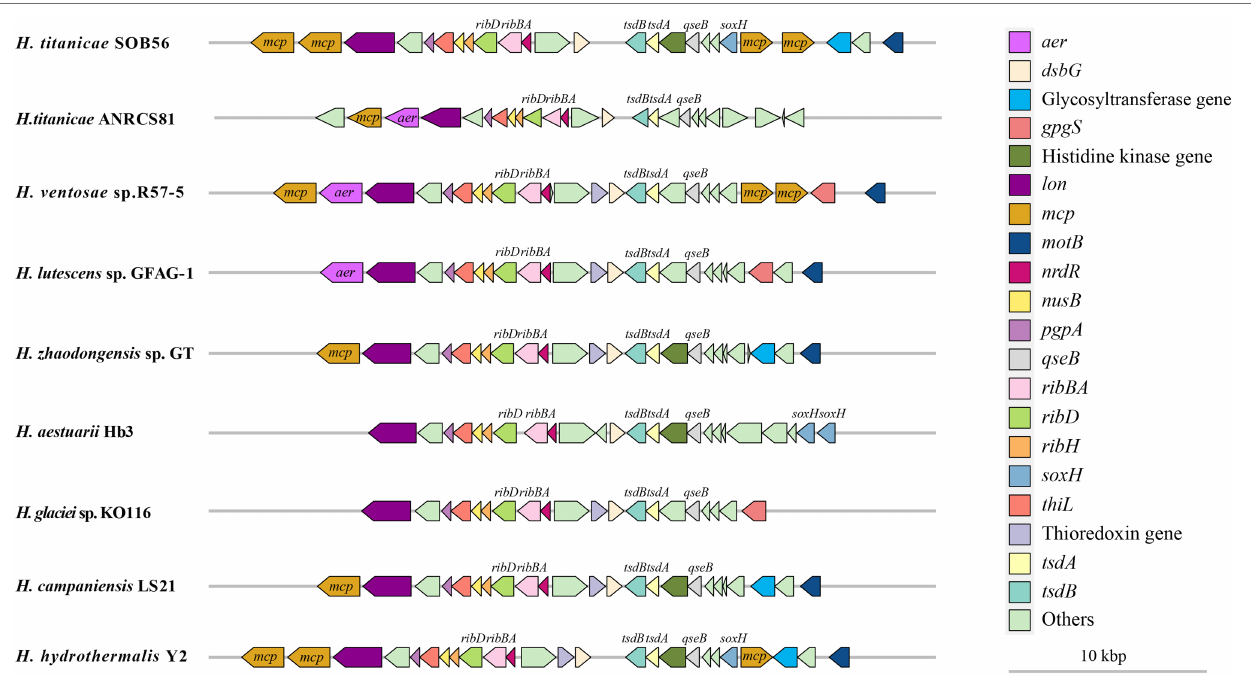
FIGURE 4 | Distribution of tsdA , tsdB , and its adjacent genes in Halomonas